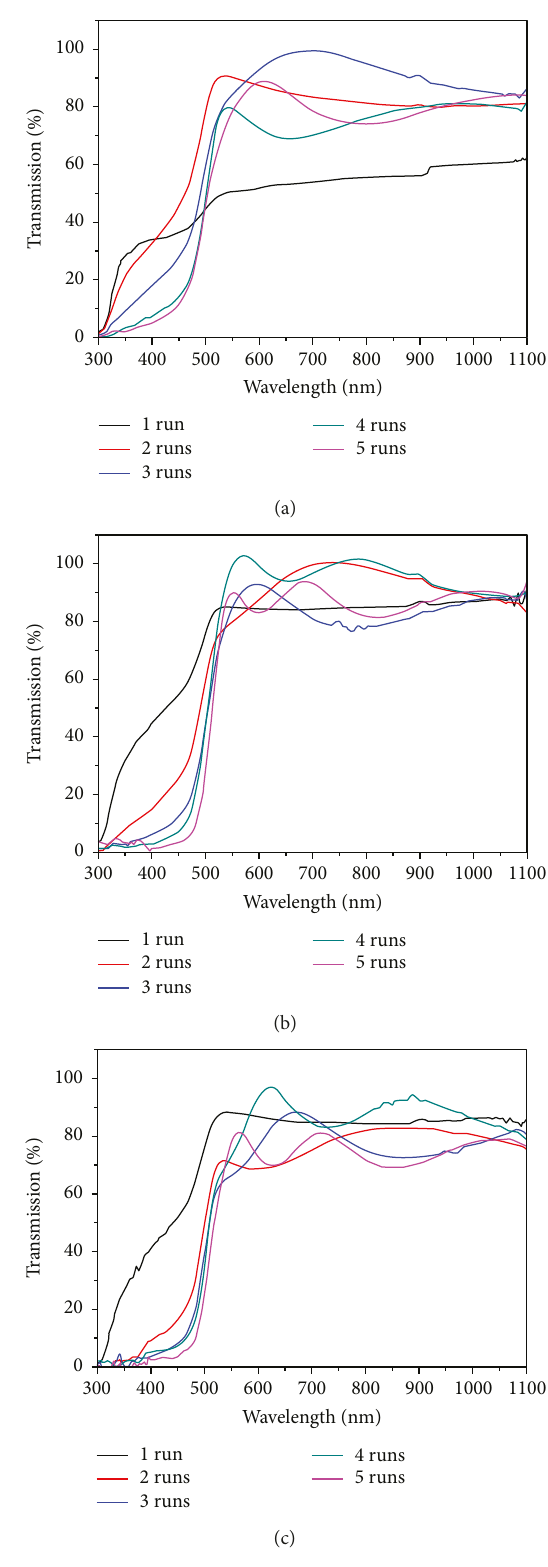
Figure 9: UV-Vis transmission spectra of CdS thin fi lms synthesized at di ff erent number of runs and deposition times: (a) 1 min, (b) 5min, and (c) 15min.